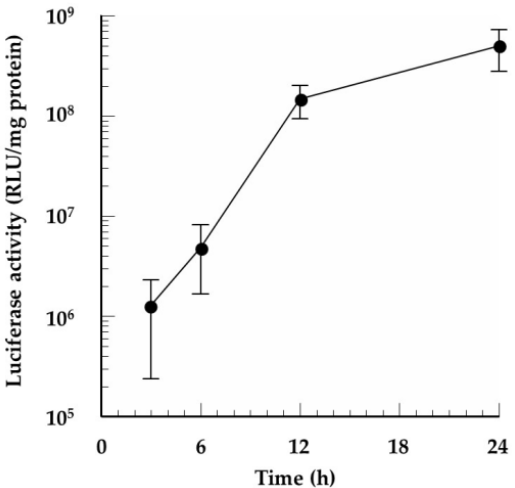
Figure 6. In vitro profile of the protein expression efficiency of mRNA/PEI8/ γ -PGA12 in B16 cells. At 3, 6, 12, and 24 h following the addition of the complex, luciferase activity was evaluated. Data represent the mean ± S.E. ( n =